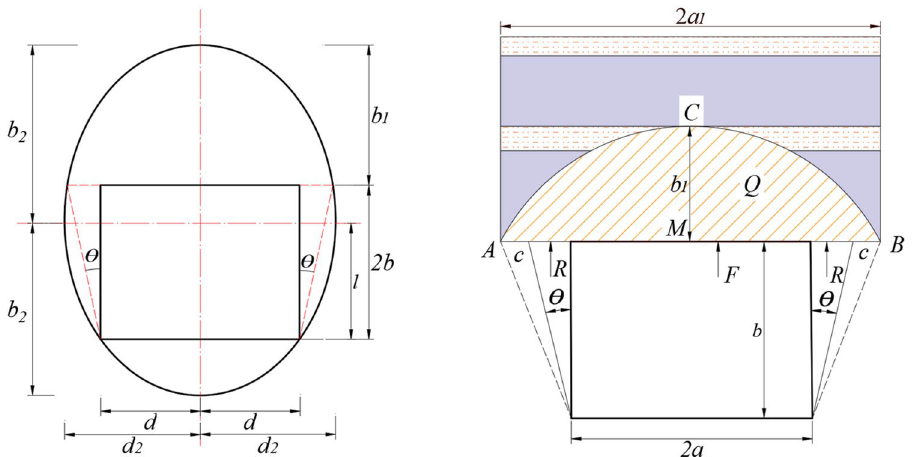
Figure 4. Relative position of limit equilibrium arch and